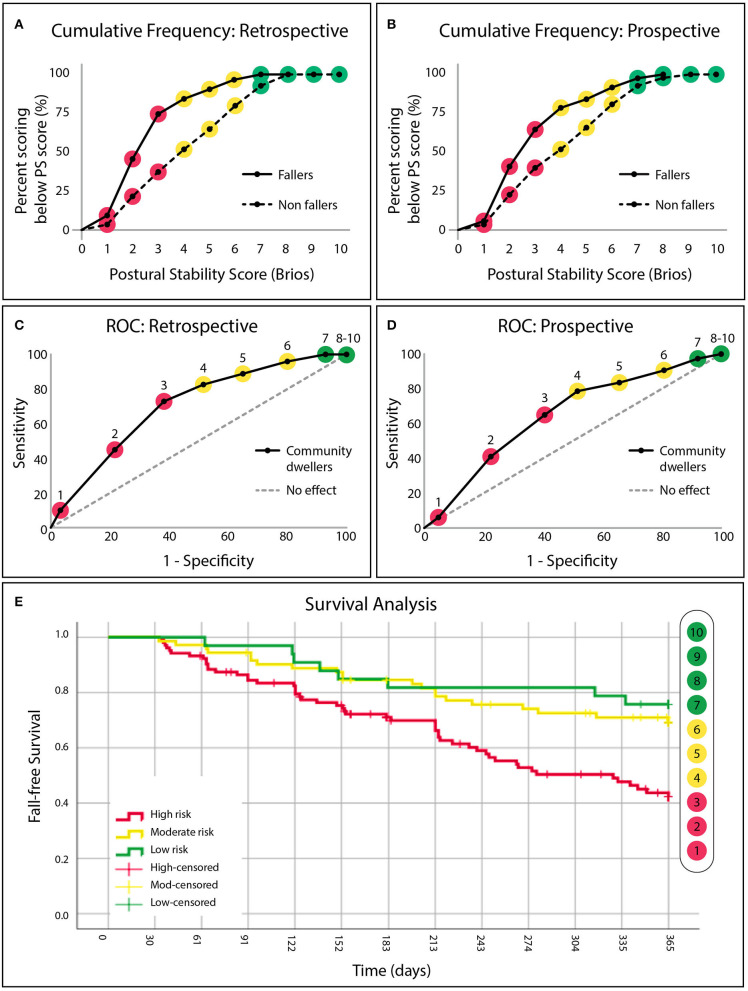
(A) The cumulative frequency distributions of the postural stability (PS) score for “fallers” and “non-fallers” identified from retrospective fall history and (B) prospective fall data. (C) Fall risk categories defined by receiver operating characteristic curves demonstrating the sensitivity and specificity of the PS score to identify community dwellers (independent senior-living residents or community recruited individuals) with a retrospective fall history. “High risk” (red, PS score: 1–3), “moderate risk” (yellow, PS score: 4–6), and “low risk” (green, PS score: 7–10) categories are defined by a change in slope. (D) Retrospectively defined risk categories applied to future falls observed in the same population after 12 months of longitudinal follow-up. (E) Cumulative survival curves denoting avoidance of a fall for all three risk categories (“‘high” in red, “moderate” in yellow and “low” in green), across 365 days (12 months).